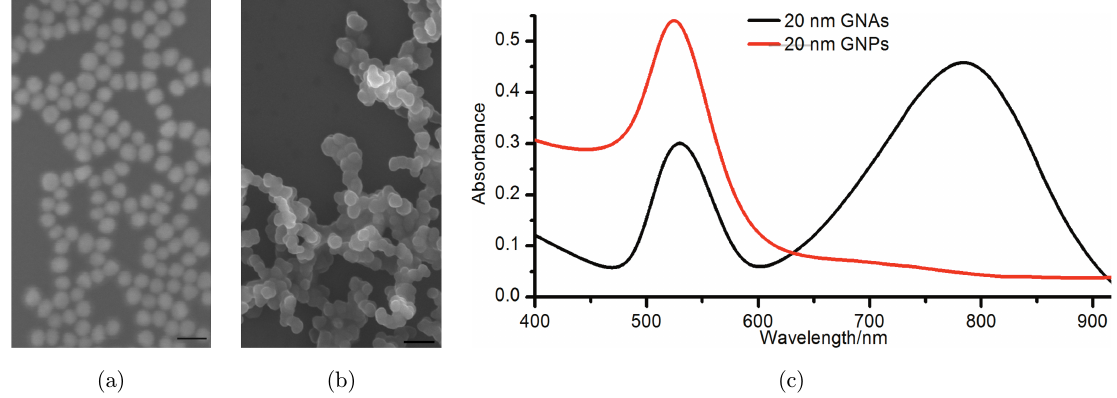
Fig. 1. SEM images of (a) GNPs with an average particle size of 20 nm and (b) the corresponding GNAs. Bar ¼ 40 nm. (c) vis-NIR absorption spectra of GNPs and GNAs. The peak absorption of GNPs is located at 523 nm. GNAs have two bands, corresponding to transverse (530 nm) and extended plasmon bands (EPB) (peaked around 780